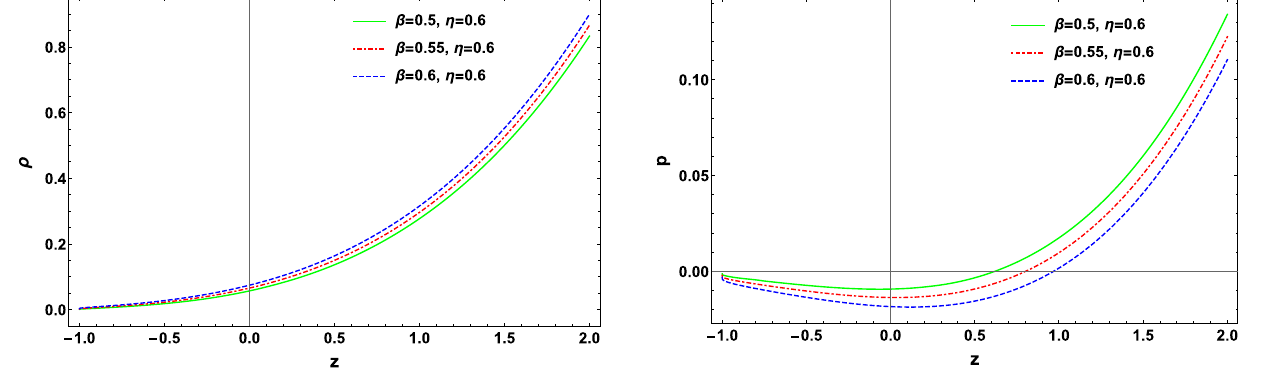
Fig. 9 Variation of energy density against z with k = 1, γ = − 2, λ = 35